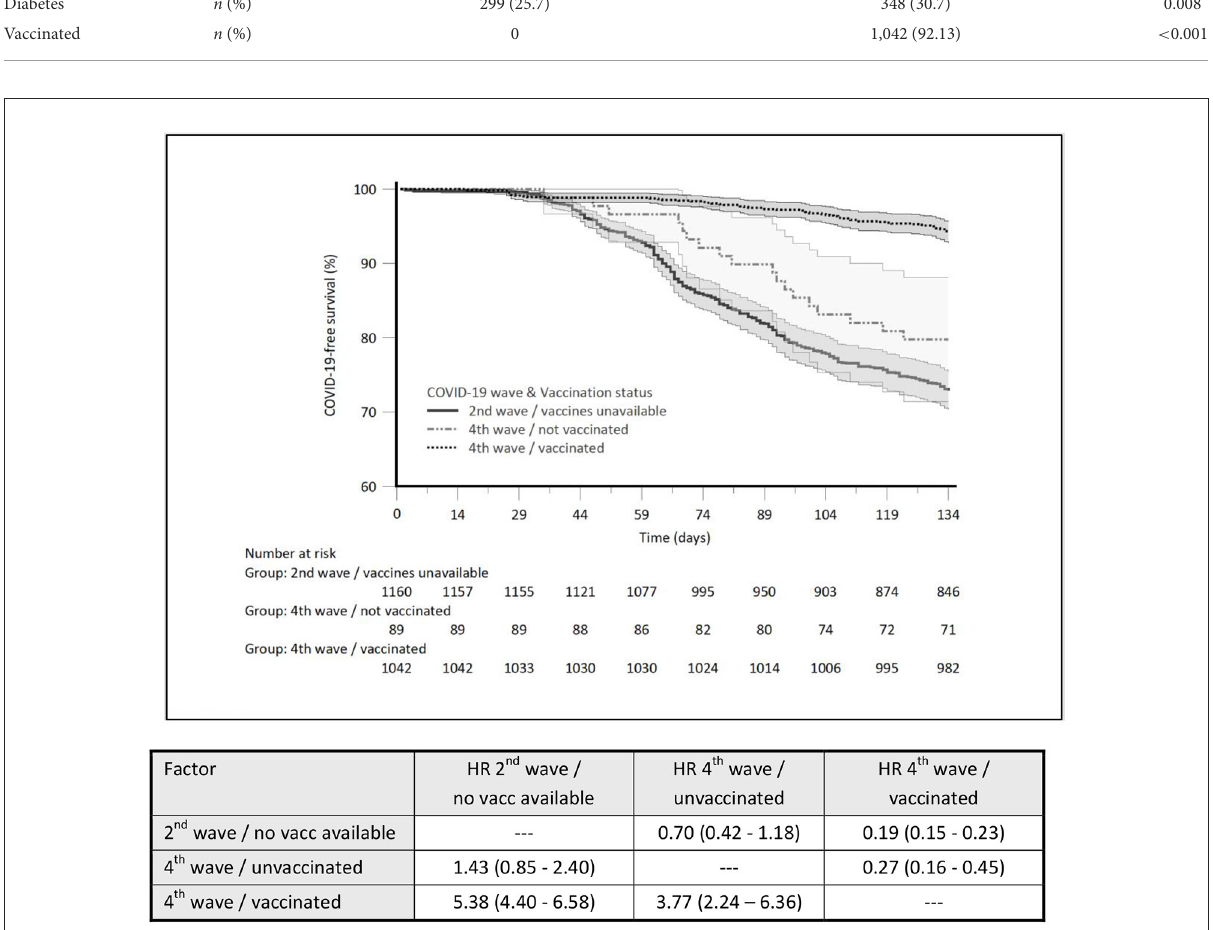
FIGURE1 The comparison of COVID-19-free survival probability (%) between the three subgroups and the hazard ratio for COVID-19-free